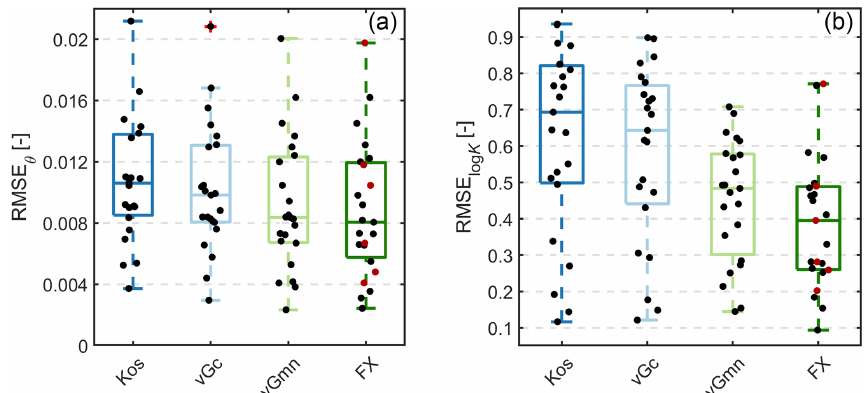
Figure 5. RMSE θ and RMSE log K for prediction of the absolute conductivity from the soil water retention function of 23 test data sets. Black dots indicate the validation data sets; red dots indicate the data sets used to estimate a general value of the saturated tortuosity coefficient τ s . The red cross indicates an outlier, defined by the MATLAB ® default settings as 1.5 times the interquartile range away from the top or bottom of the box (https://de.mathworks.com/help/matlab/ref/boxchart.html, last access: 13 April 2023).